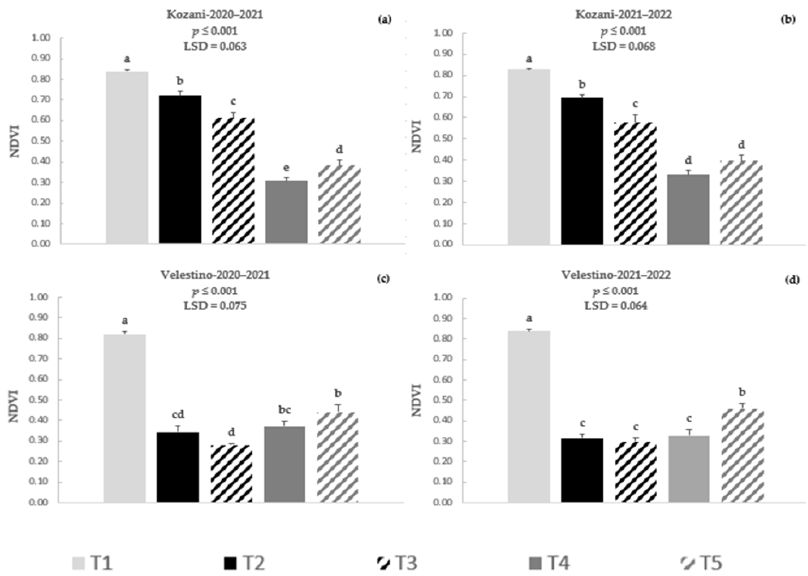
Figure 1. Weed NDVI in ( a ) Kozani-2020–2021, ( b ) Kozani-2021–2022, ( c ) Velestino-2020–2021, and ( d ) Velestino-2021–2022. Treatment DF: 4; Error DF = 15; Total DF = 19; DF: Degrees of Freedom. At each site-year, different lowercase letters indicate significant differences between treatment means according to Fisher’s LSD test ( a = 0.05). Vertical bars indicate standard errors.